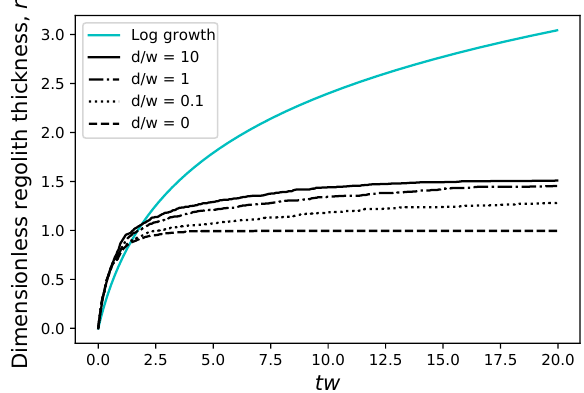
Figure 13. Comparison between rate of material input, 1 /τ (cells / year), with effective rate of weathering, wn ra /n H , from 125 model runs (see text).